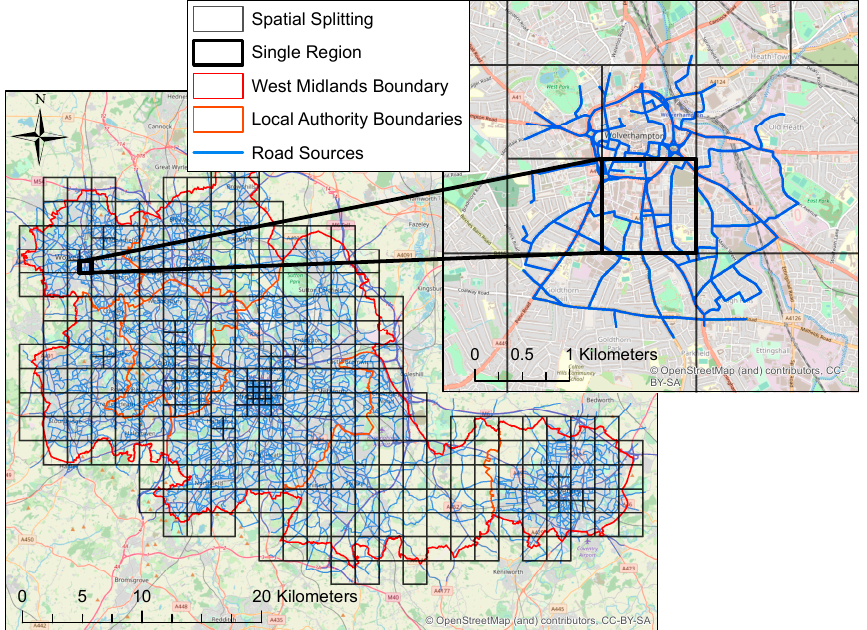
Figure 1. Example of explicit road source truncation for a particular sub-region. A buffer zone of 750 m has been used. Note that spatial sub-regions outside the WM boundary are run in the model but not included in contour output, and thus are not shown